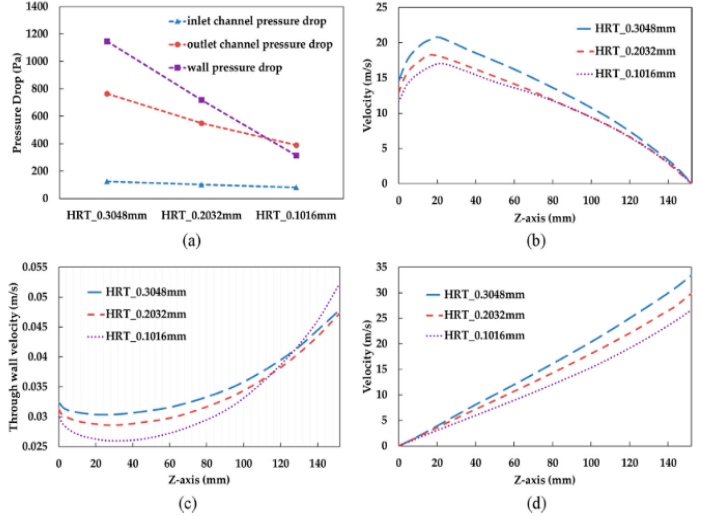
Figure 12. Flow and pressure drop characteristics of HRT with different wall thicknesses under a clean wall condition: ( a ) Pressure drop composition; ( b ) Inlet channel velocity; ( c ) Wall penetration velocity; and ( d ) Outlet channel velocity [149].